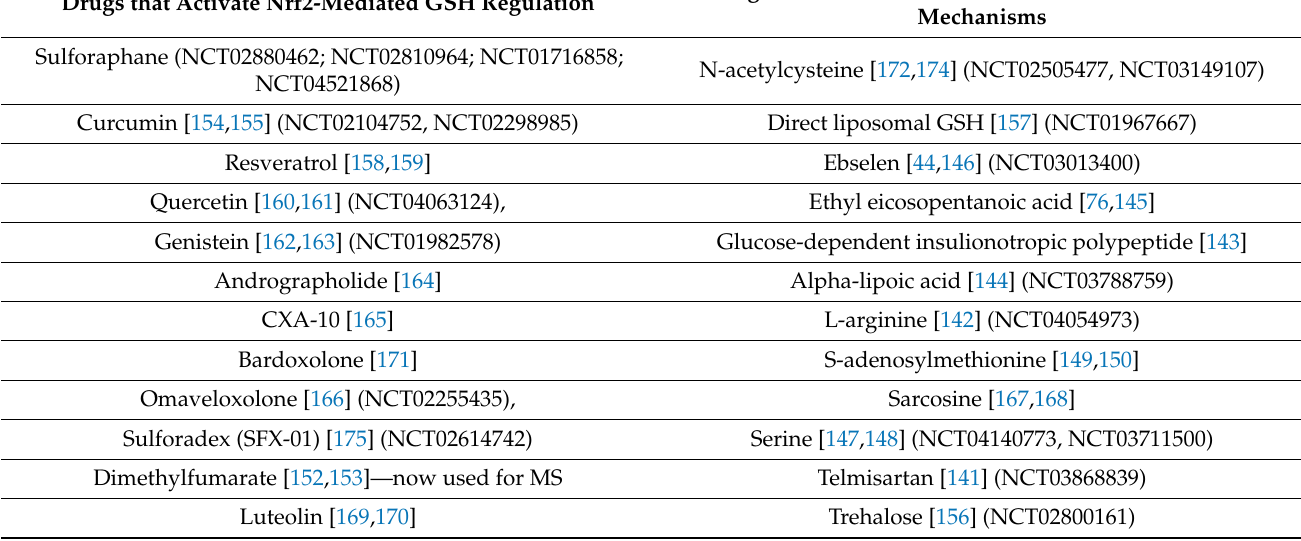
Table 2. Potential therapeutic agents that can alter intracortical GSH. Drugs that Increase or Stabilise GSH Levels via